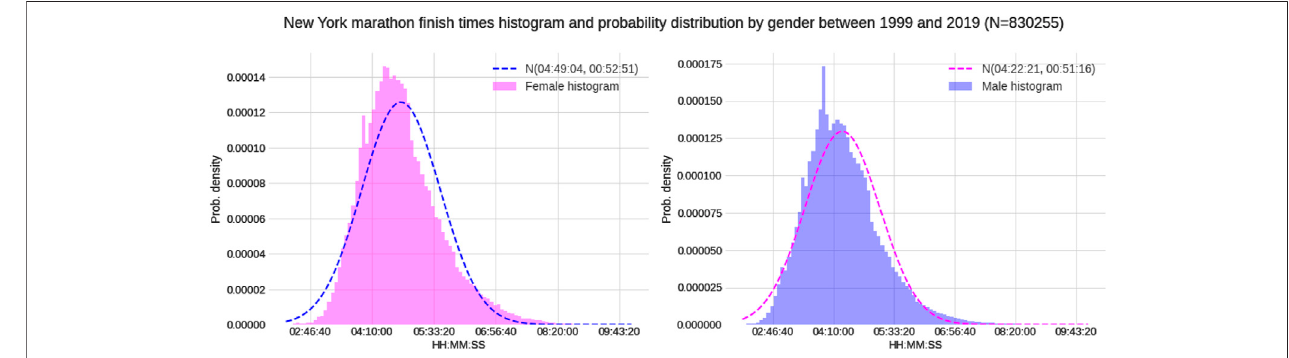
FIGURE 1 | Histograms of female and male race times in the “ New York City Marathon ” .